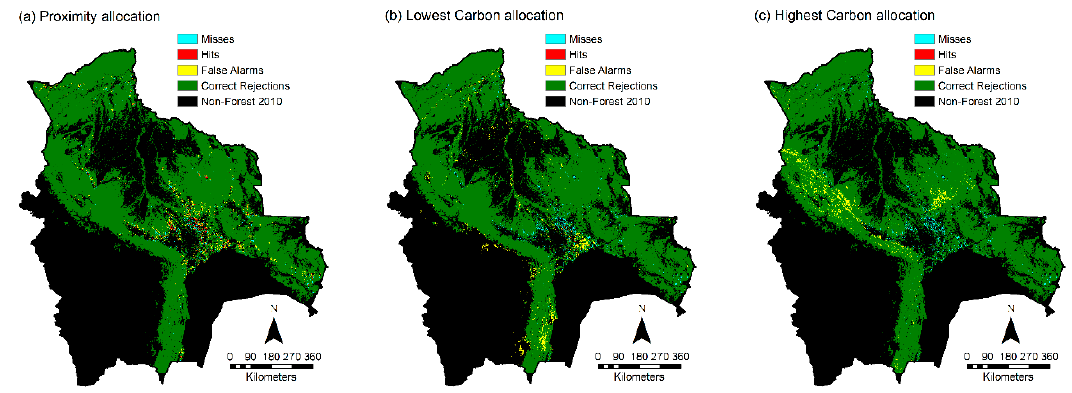
Figure 9. Confirmation maps for ( a ) Proximity, ( b ) Lowest Carbon and ( c ) Highest Carbon.